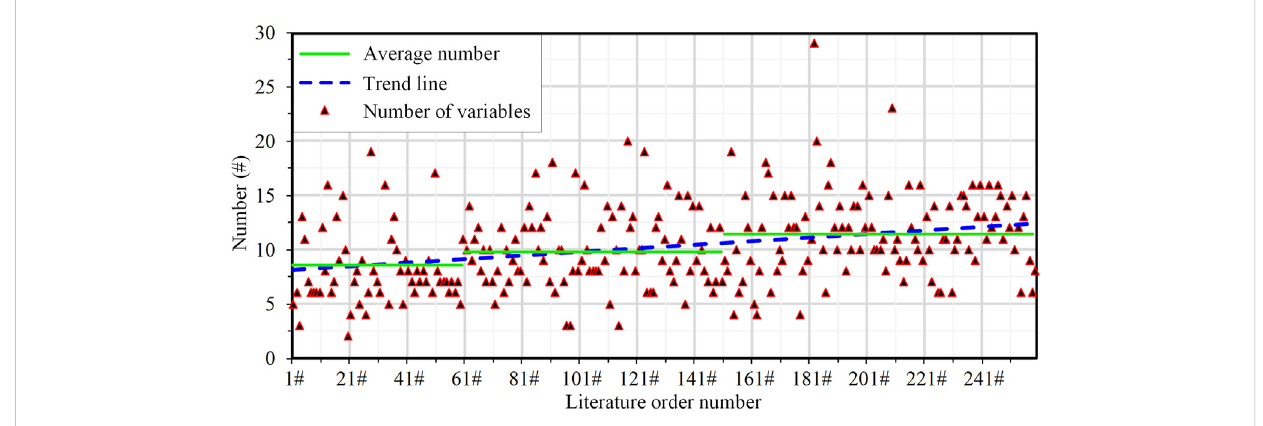
FIGURE 1 Number of environmental variables applied from the literature database. The order numbers are listed in chronological order of the literature.